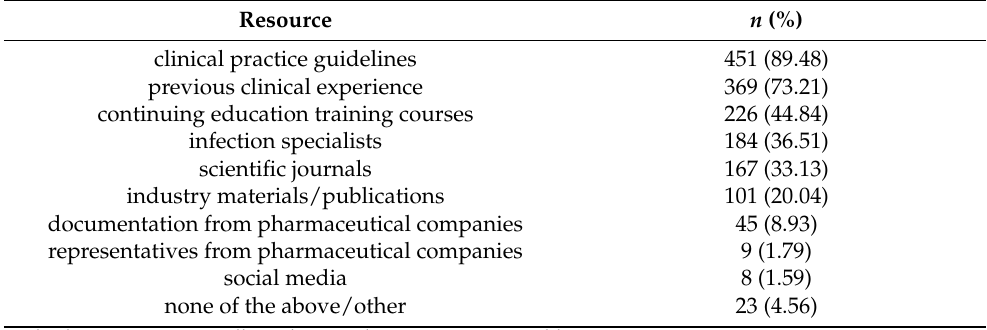
Table 1. Resources most frequently used by medical doctors in the management of infections ( n = 504).